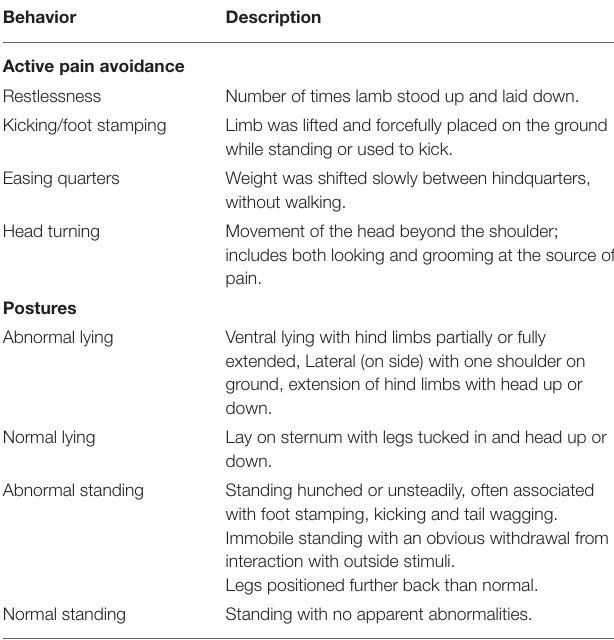
TABLE 1 | Ethogram used for behavioral observations of lamb’s sham castrated and tail-docked, or castrated and tail-docked with rubber rings. Behavior